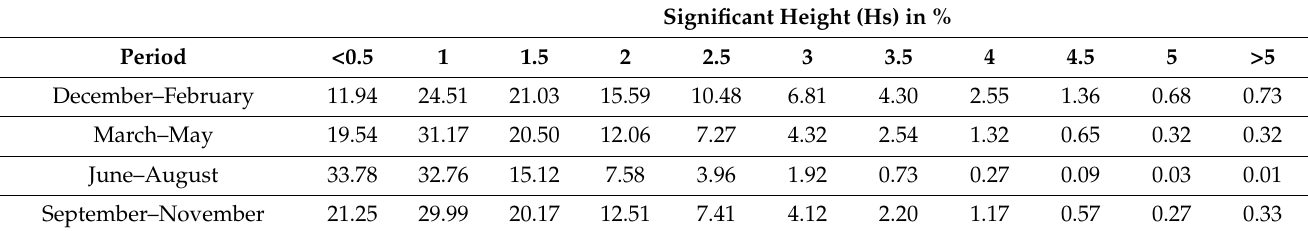
Table 3. Average seasonal Distribution for the area 3. Source: